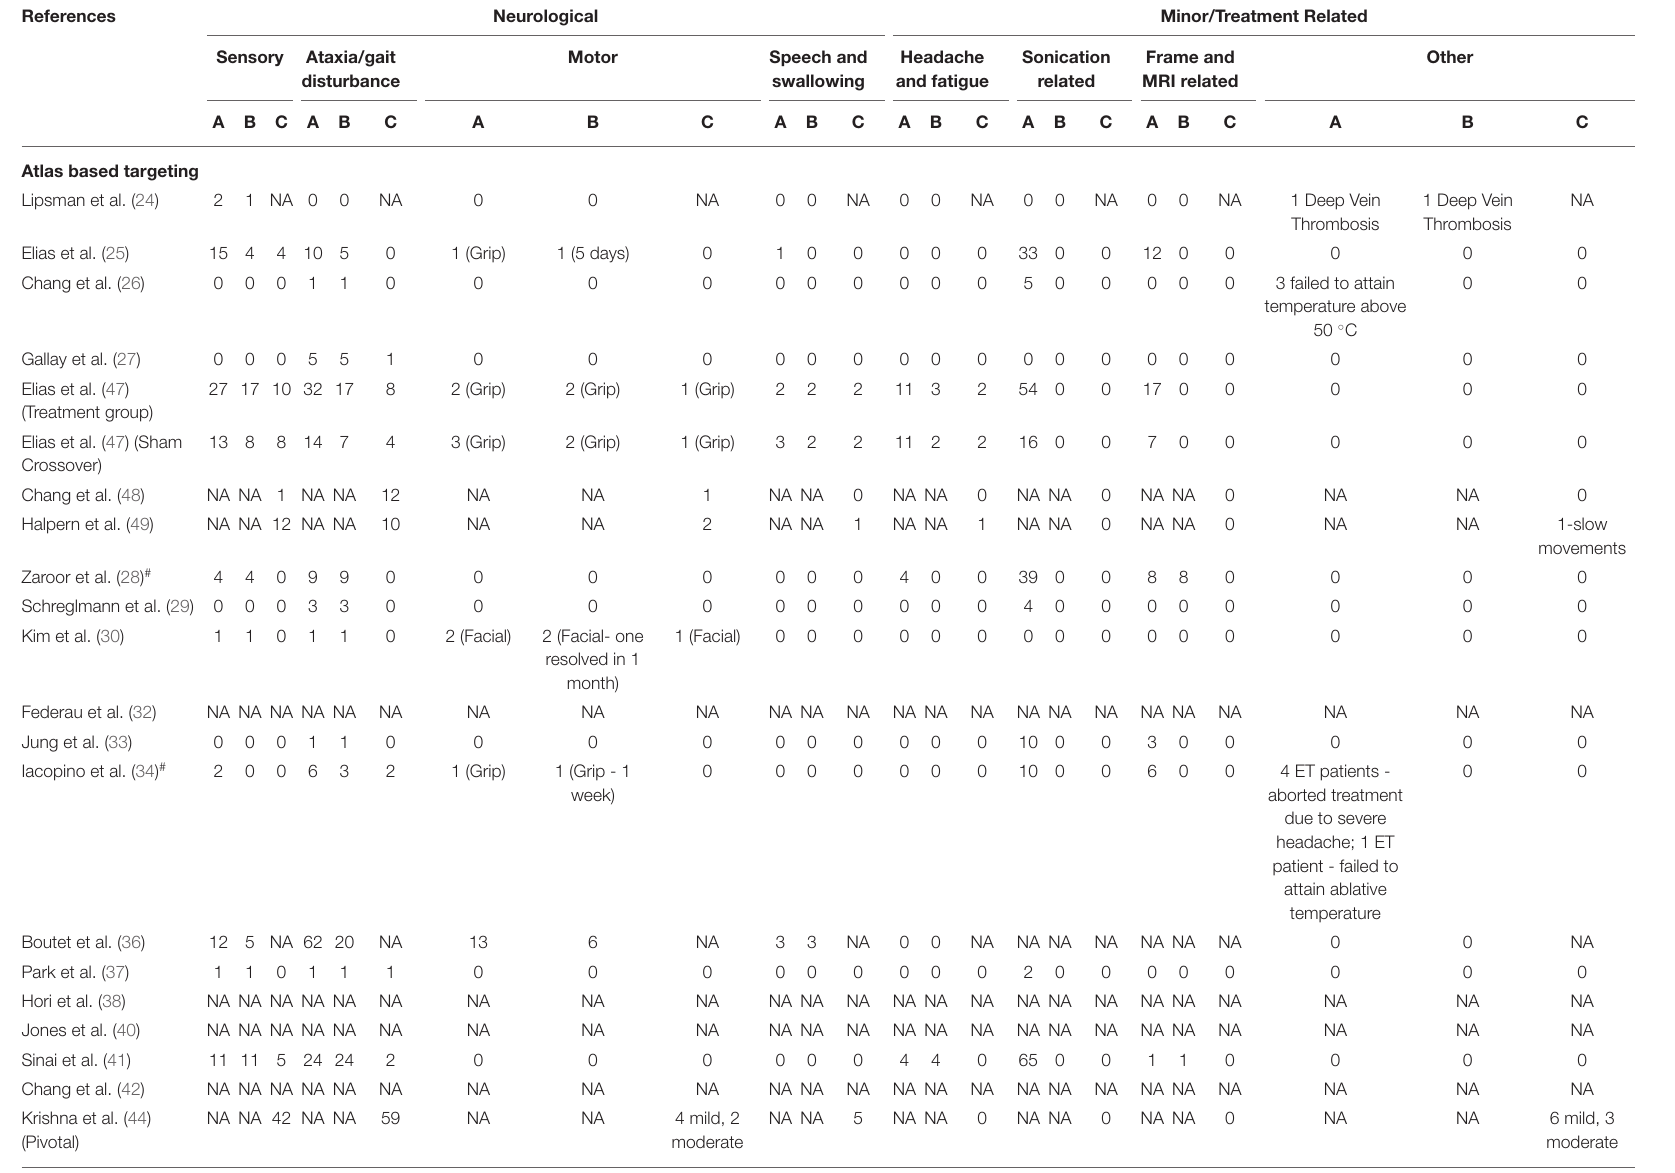
TABLE 5 | Total number of complications (grouped according to the targeting